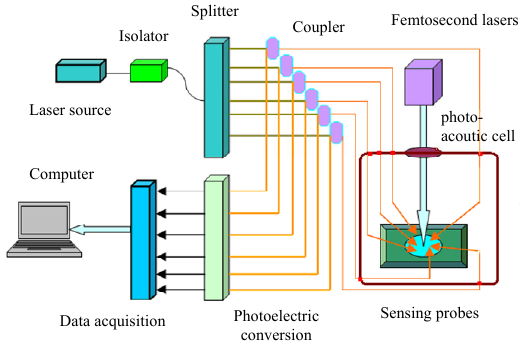
Fig. 1 Experimental device